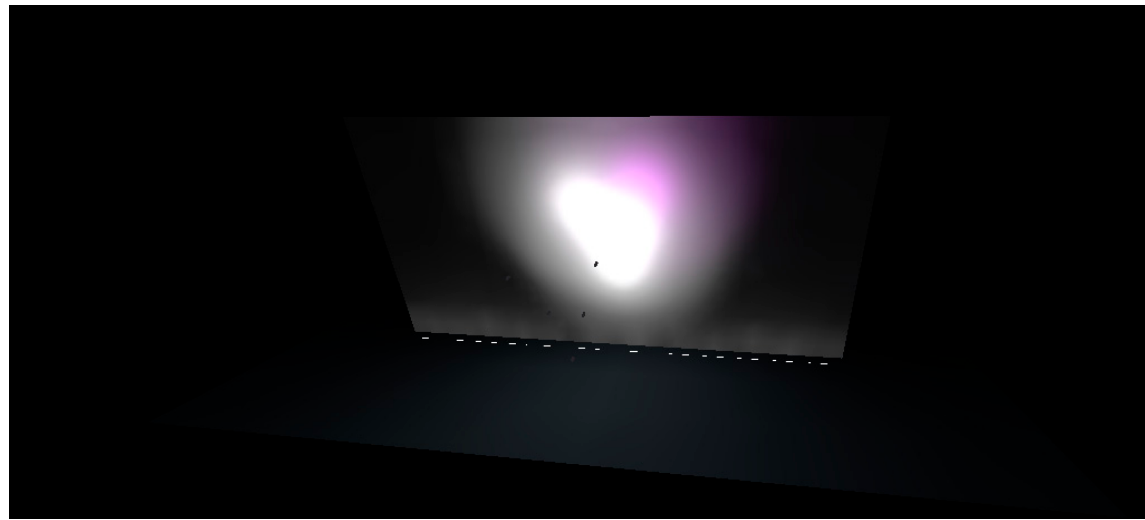
Figure 11. Simulation of visual result of Working Diagram I—Scene 4.